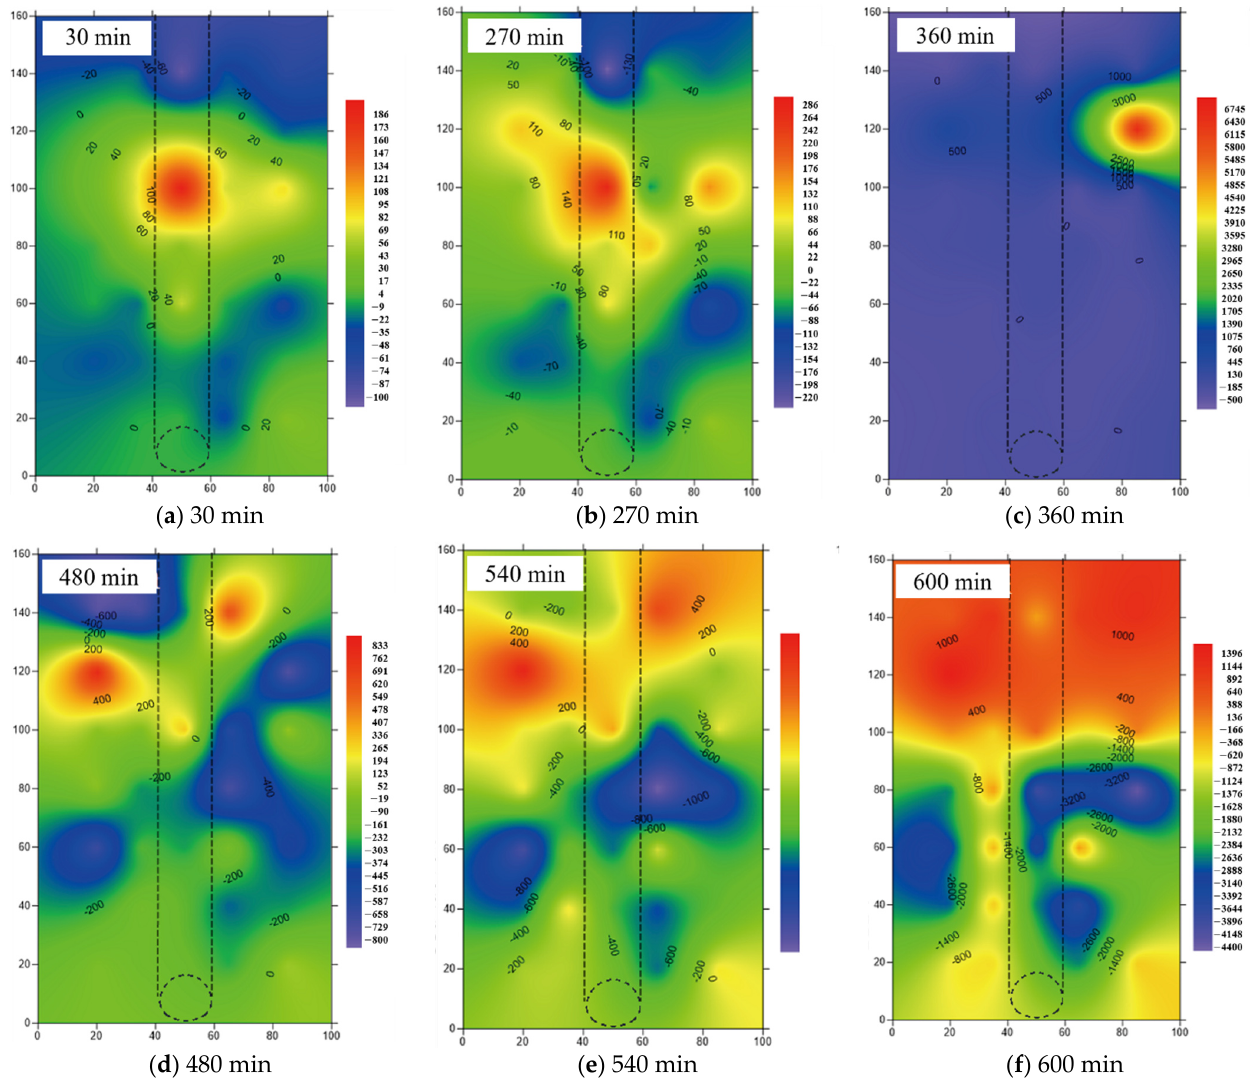
Figure 11. Loess-bedrock interface deformation contour measured by strain gauges 600 min into the